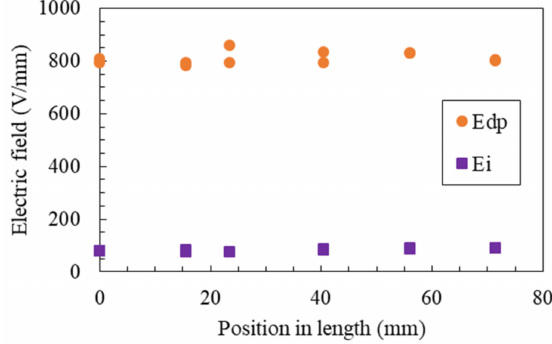
Figure 6. Distributions of E d and E i along the growth direction for the Mn:PIN-PMN-PT boule.